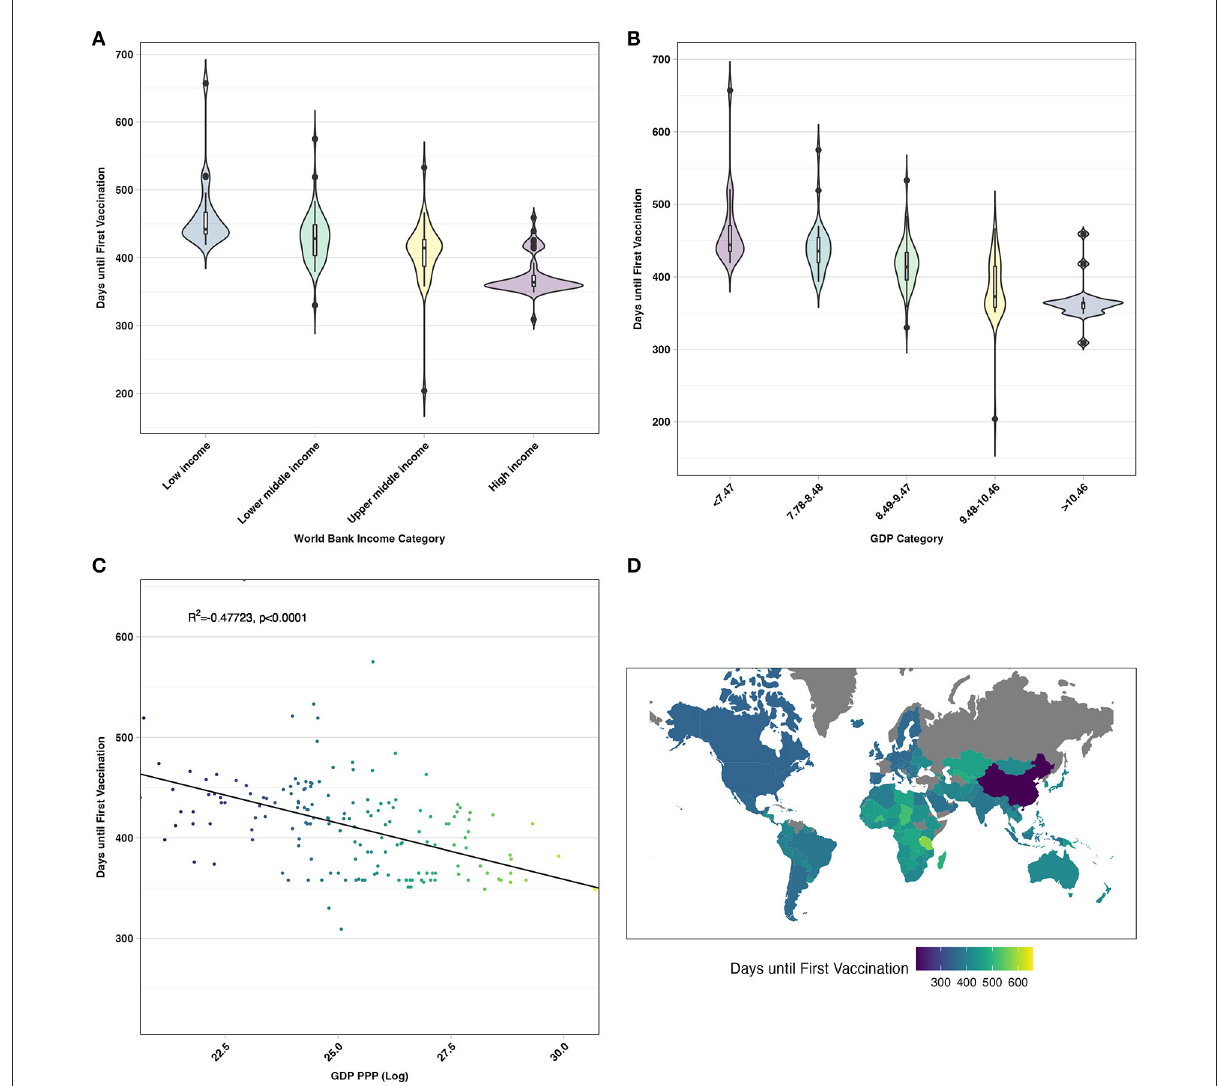
FIGURE1 (A) Comparing the distribution of days until the first vaccination between world bank income categories. (B) Comparing the distribution of days until the first vaccination by log-GDP PPP per capita category. (C) Comparing days until first vaccination and log-crude GDP PPP. (D) Choropleth of days until the first vaccination by country, with lighter shades indicating a longer time to report the first COVID-19